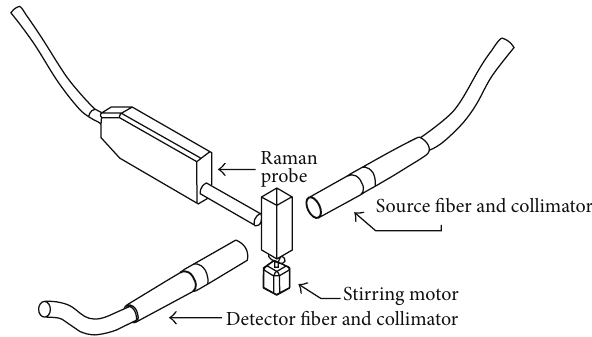
Figure 1: Schematic of the experimental apparatus. A fast-stirred fluorescence cuvette is interrogated by both a backscattering Raman probe and a transmission visible extinction probe. The two focal points (Raman and visible) are offset by several